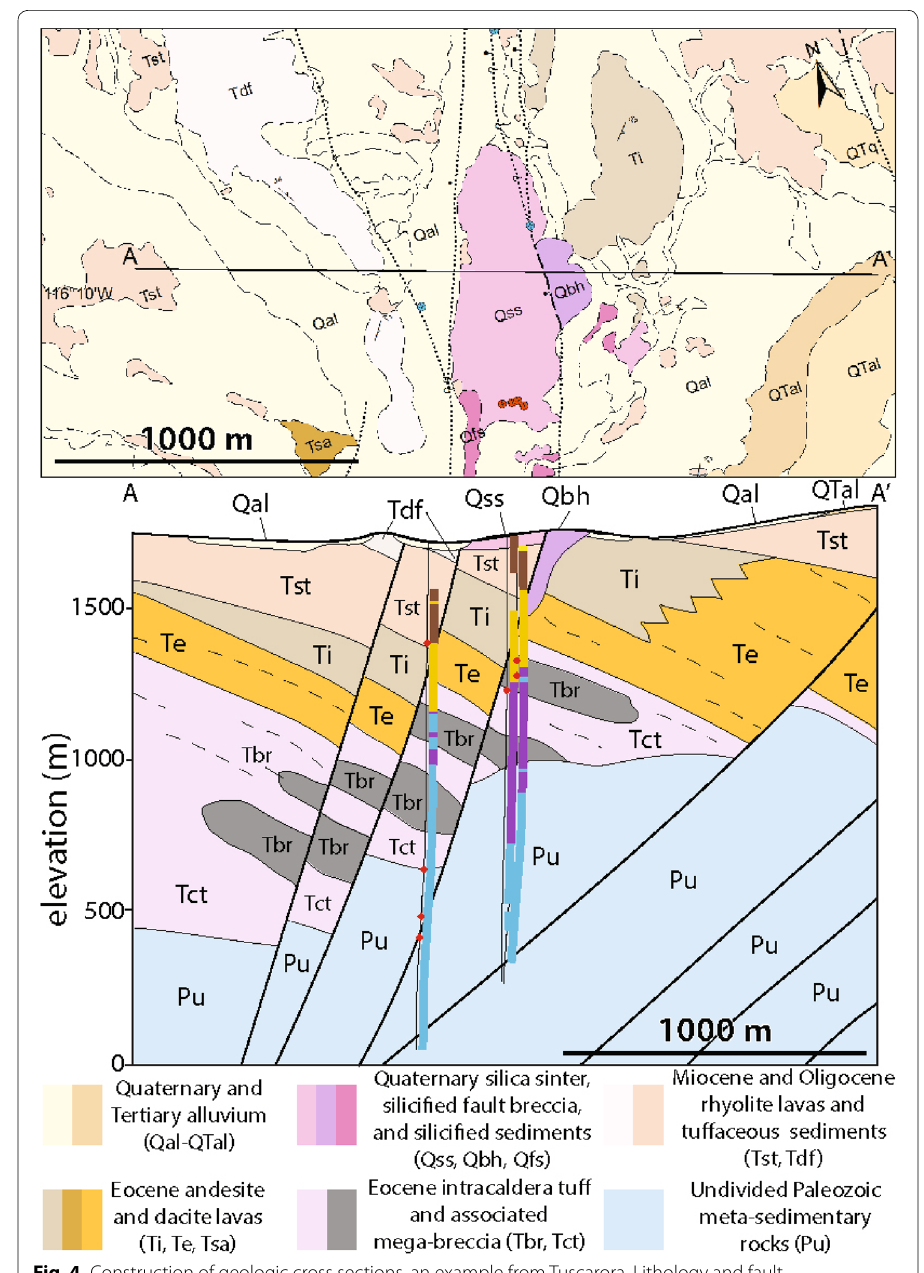
Fig. 4 Construction of geologic cross sections, an example from Tuscarora. Lithology and fault interpretations from cuttings and core, along with the locations of partial and complete lost circulation zones (red diamonds) are plotted along well paths. Wells within 500 m of the cross-sectional plane are projected to the section, so all the wells shown are not exactly in the cross-sectional plane. A strip of the geologic map along the cross-sectional line (top) indicates the surface locations of mapped faults and geologic contacts. The cross section is constructed based on the map data and other available subsurface data, such as seismic reflection and potential field data (not Downhole data Data from boreholes provide key constraints on structure and stratigraphy at depth (e.g., Fig. 4). Lithologic analysis from core is the best constraint on subsurface stratigraphy,